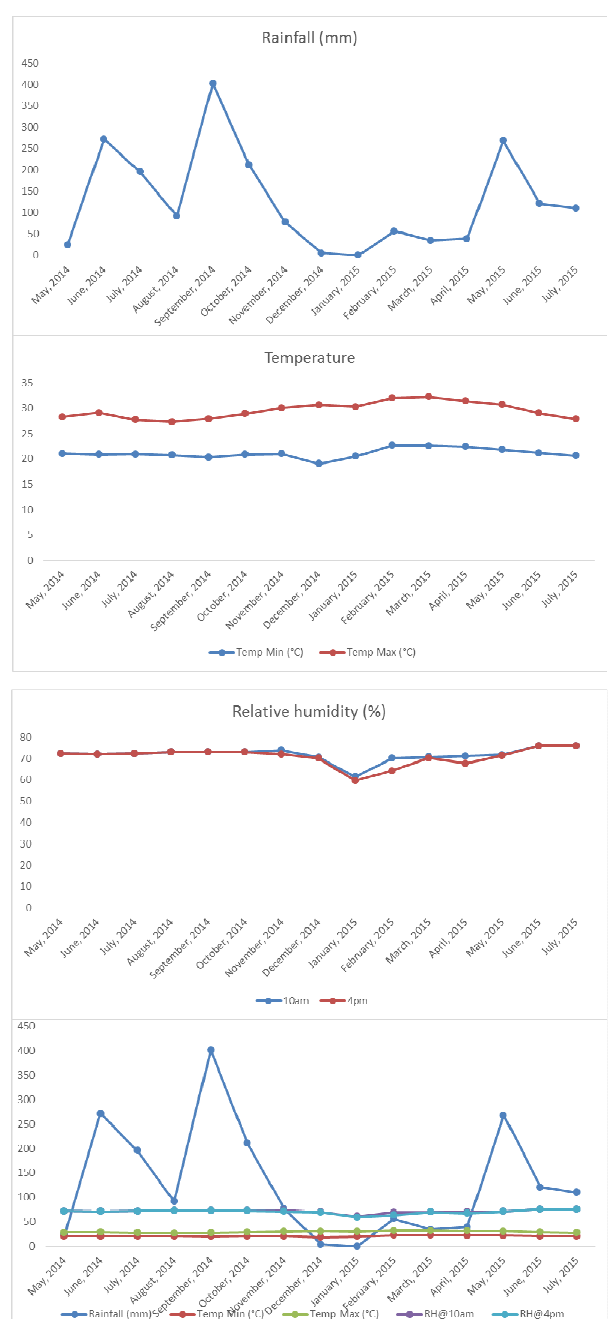
Fig. 1. Mean monthly rainfall (mm), temperature (°C), and relative humidity (%) during the period of study (2014-2015) Source: Meteorological station, Department of Crop Science, University of